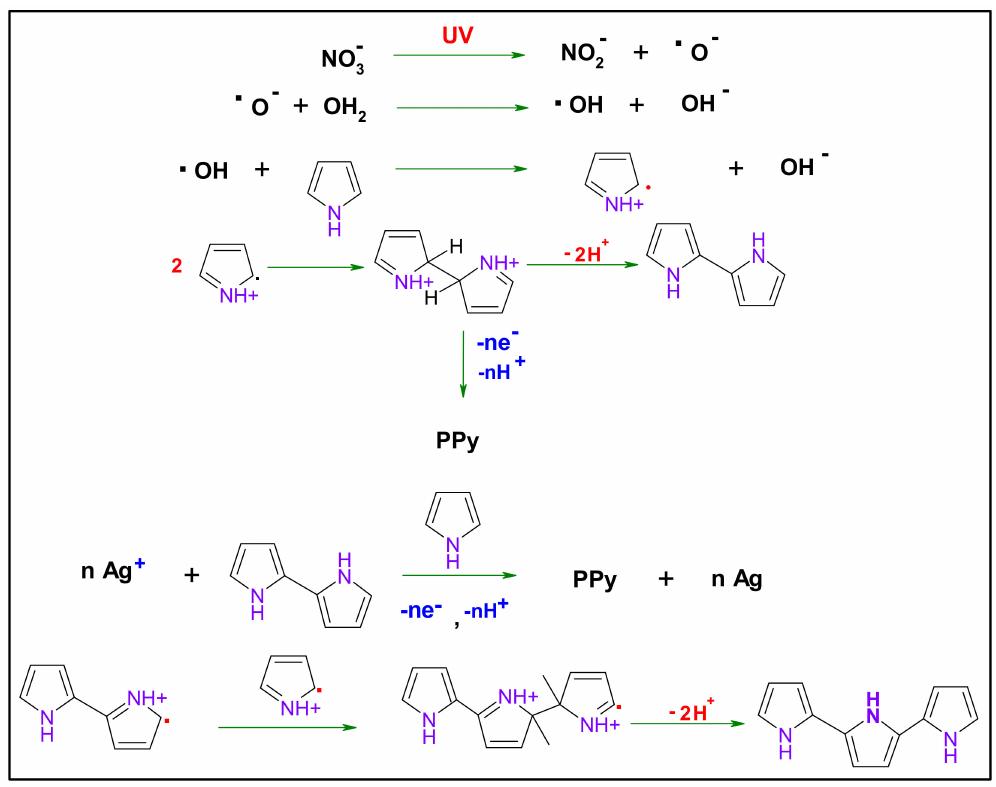
Figure 3. Pyrrole photopolymerization mechanism in the presence of silver nitrate photosensitizer